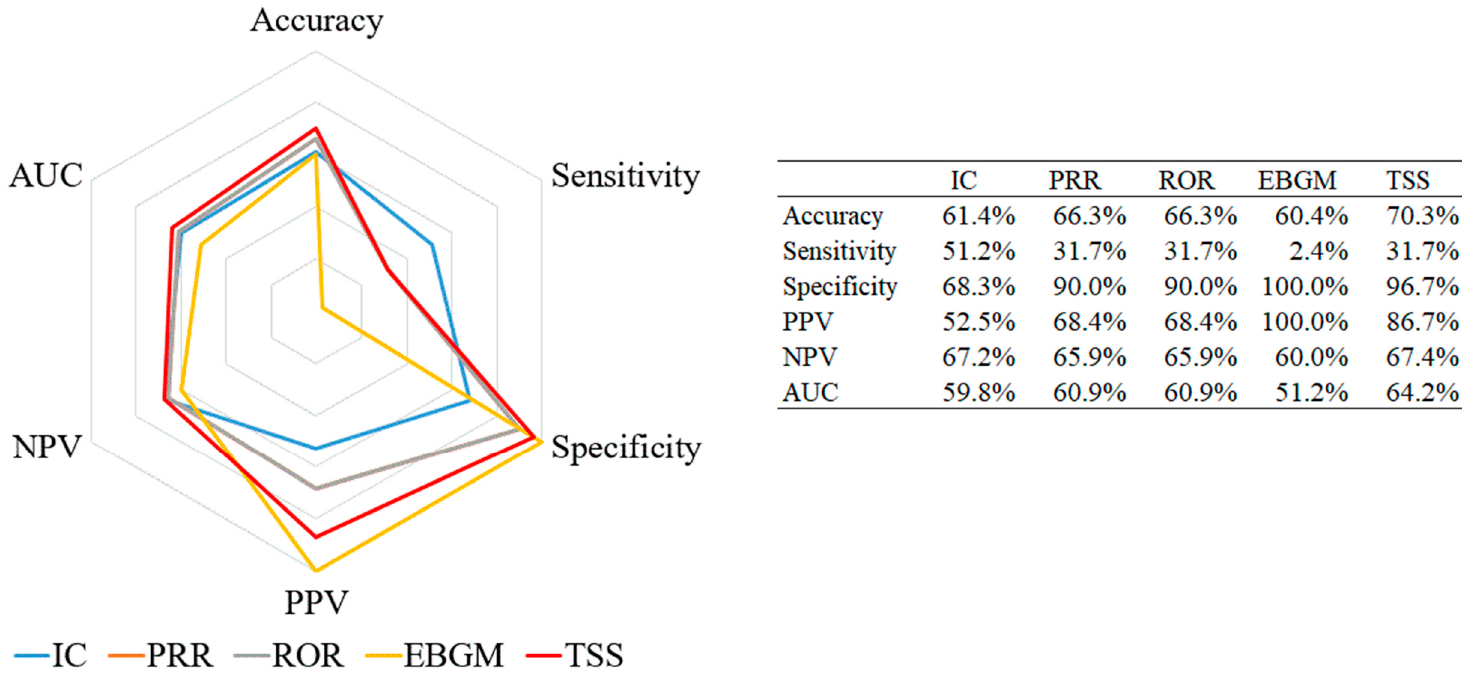
Figure 2. Radar chart of performance measurements for signal detection algorithms about pneumococcal vaccine. Abbreviations: IC, information component; PRR, proportional reporting ratio; ROR, reporting odds ratio; EBGM, empirical Bayes geometric mean; TSS, tree-based scan statistic; PPV, positive predicted value; NPV, negative predicted value; AUC, area under the curve.